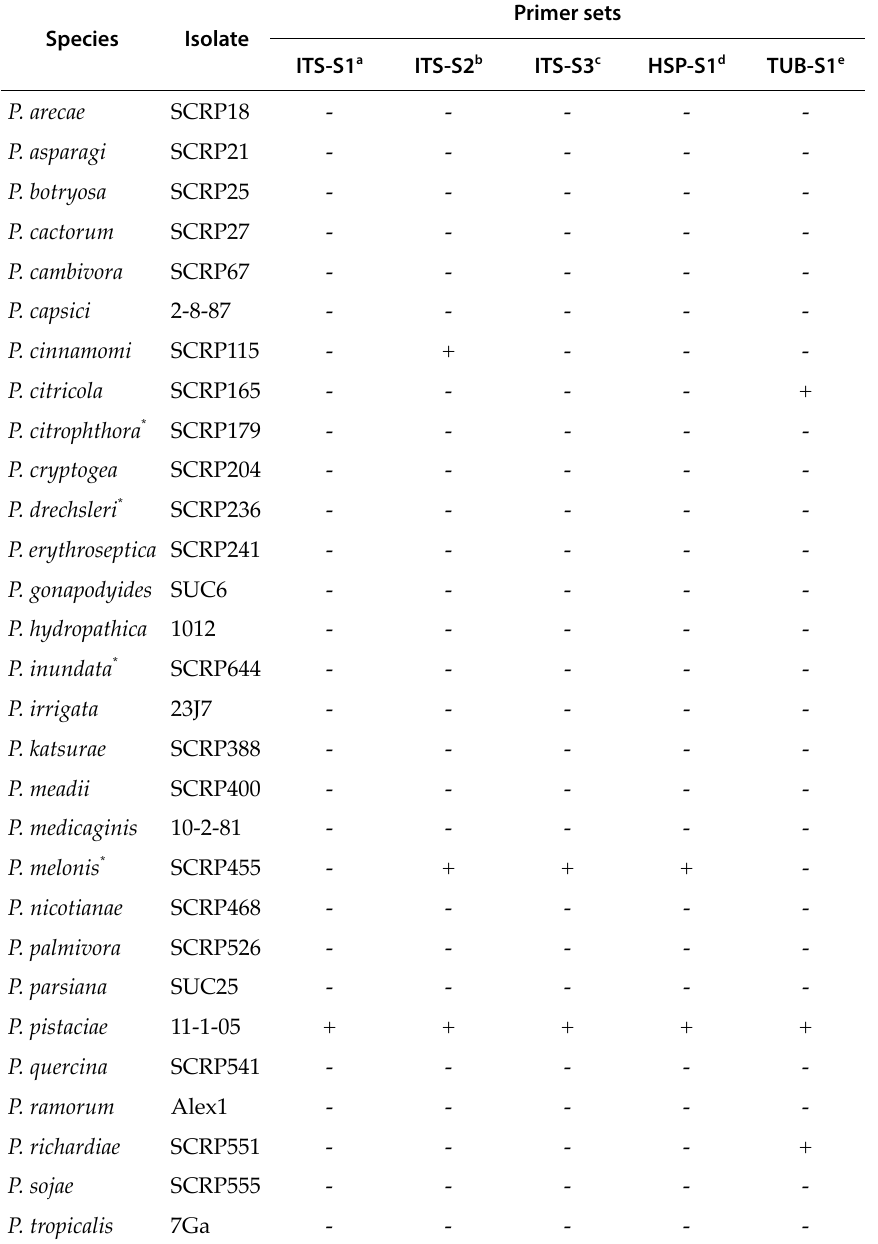
Table 2. Species-specific amplification of DNA sequences from different Phytophthora species by designed primer sets for Phytophthora pistaciae